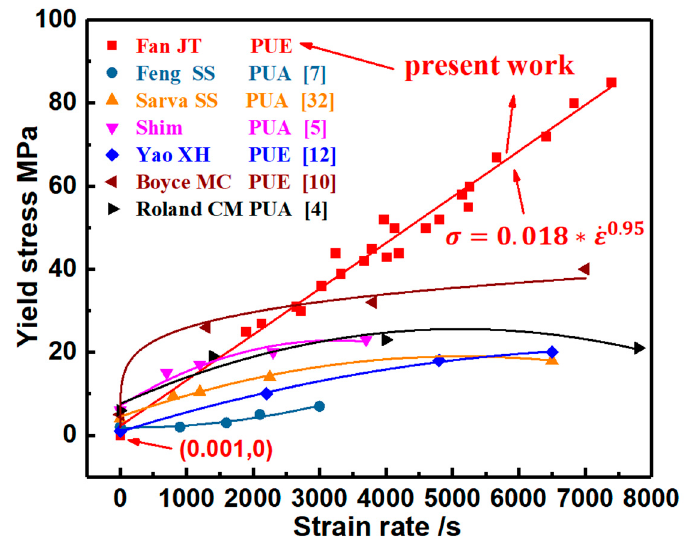
Figure 6. Improvement in the dynamic yield stress of the developed PUE material is at a higher strain rate as compared with the reported elastomers of polyurea (PUA) and polyurethane elastomer (PUE), indicating an enhancement in impact resistance.